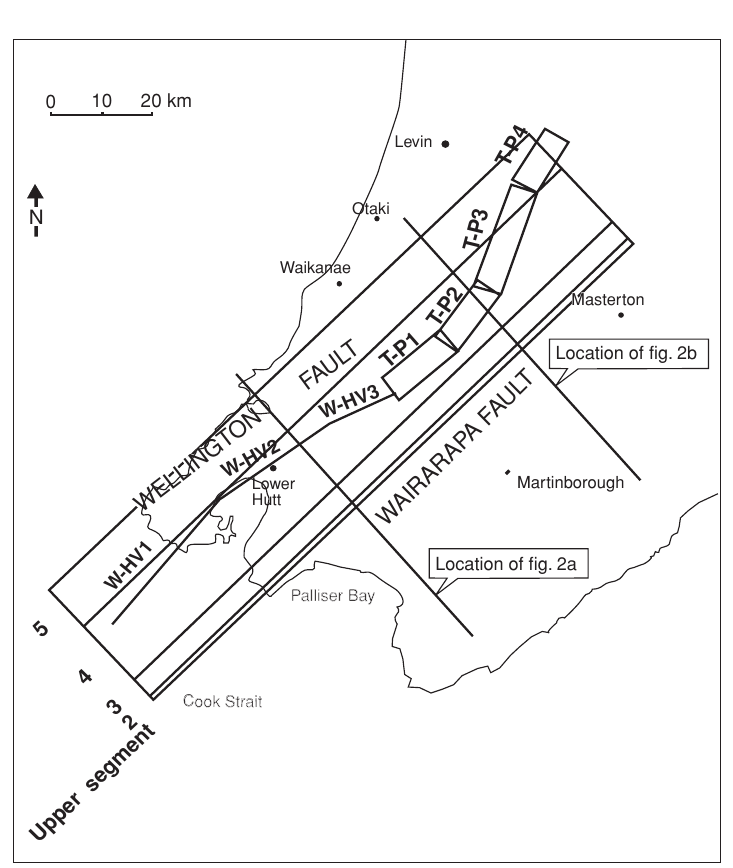
Fig. 3. The surface projections of the Wairarapa Fault, and the W-HV segment and T-P segment of the Wellington Fault. The listric Wairarapa Fault for computational simplicity is approximated by a sequence of five planar seg- ments of increasing dip upward, all with the same length of 130 km (Darby and Beanland,